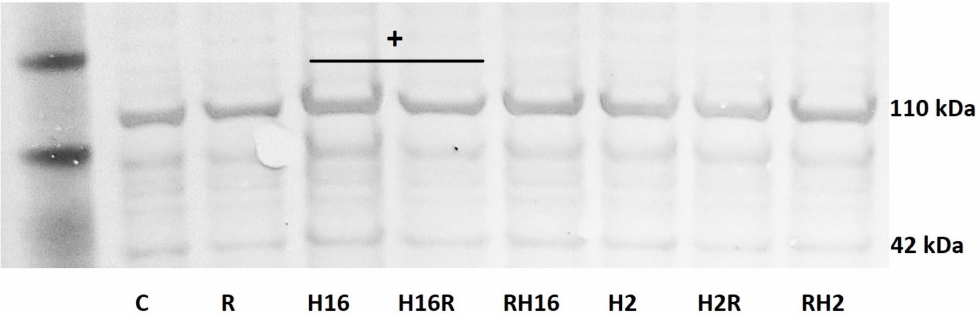
Figure 2. Immunoblot confirmation of relaxin effects. The results are from the HFL1 fibroblast cell line, presenting relaxin (R) influence on collagen I protein expression. Collagen type I (COL1) consists of two α 1 (COL1A1) chains and one α 2 chain (COL1A2, presented here, 110 kDa), which is a hallmark of fibrosis. The results mirror the expression obtained on the mRNA level. OD (Odds Ratio for H16 = 84 vs. OD for H16R = 72, + p < 0.05 in comparison to the rhinovirus sample (HRV-2 or HRV-16, respectively)); C—control sample with medium only. N = 3, β -actin (42 kDa) was an endogenous control. H16R, H2R—rhinovirus 16 and 2 added first, followed by relaxin—after 24 h, as well as RH16, RH2—relaxin added first, followed by rhinovirus 16 and 2—added after 24